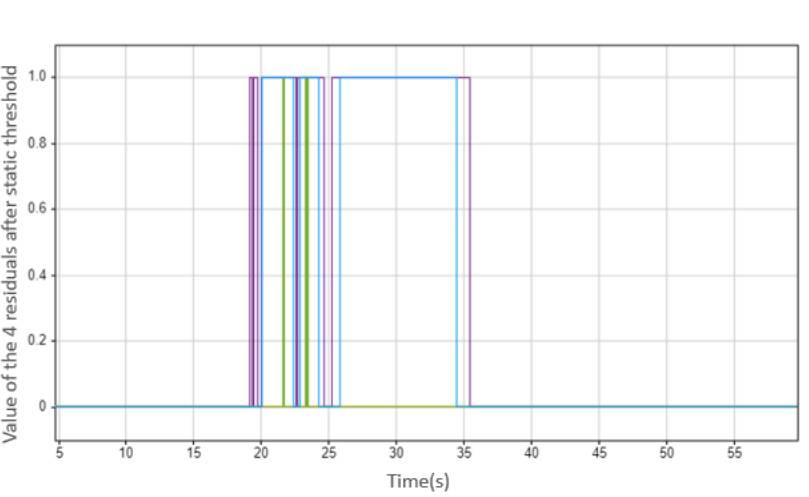
Figure 23. The values of the four residuals after threshold, this case is that when IMU sensor fails between 20 s and 40 s (0 means there is no abnormal situation, 1 means there is an abnormal